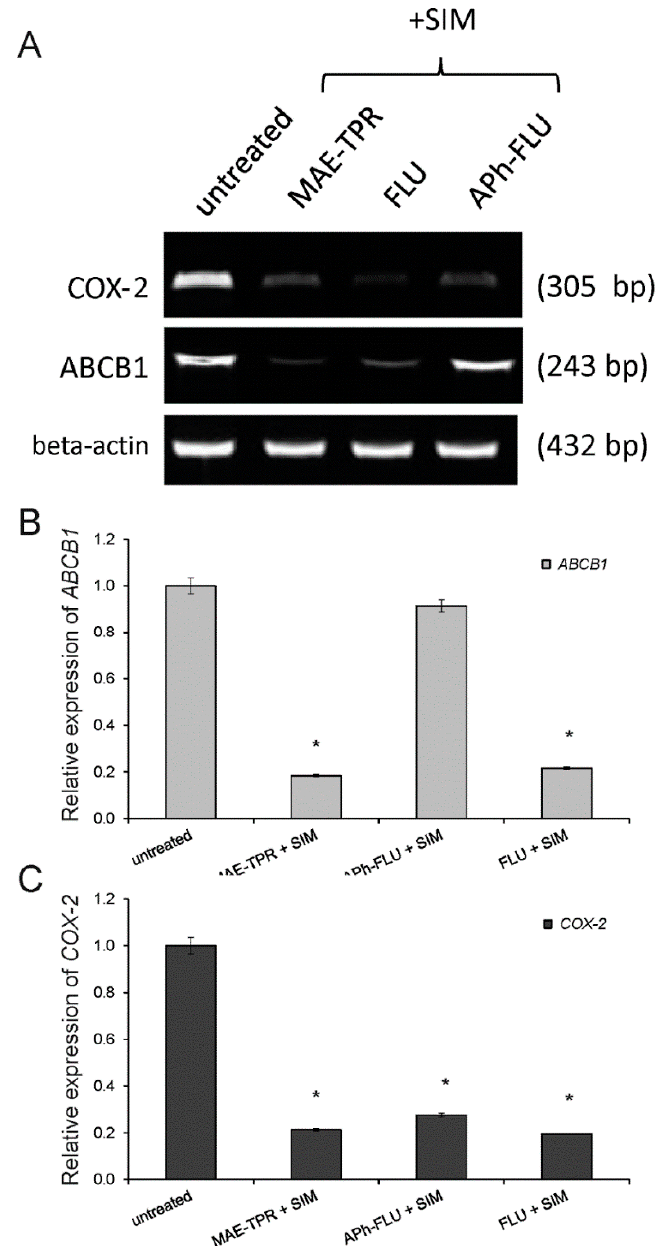
Figure 5. Analysis of COX-2 (dark grey bars) and ABCB1 genes (light grey bars) expression in LoVo/Dx cells cultured with phenothiazine derivatives and simvastatin (SIM) in combination ( A ) for 48 h. The base pair lengths of the amplified products are indicated at the right side of the gel. β -actin was used as a reference gene. The relative level of ABCB1 ( B ) and COX-2 expression ( C ) normalized to the control derived from non-treated LoVo/Dx cells. The results of three experiments ± SD are presented. The statistically significant differences from the untreated controls were determined using Student’s t -test (* p < 0.05).